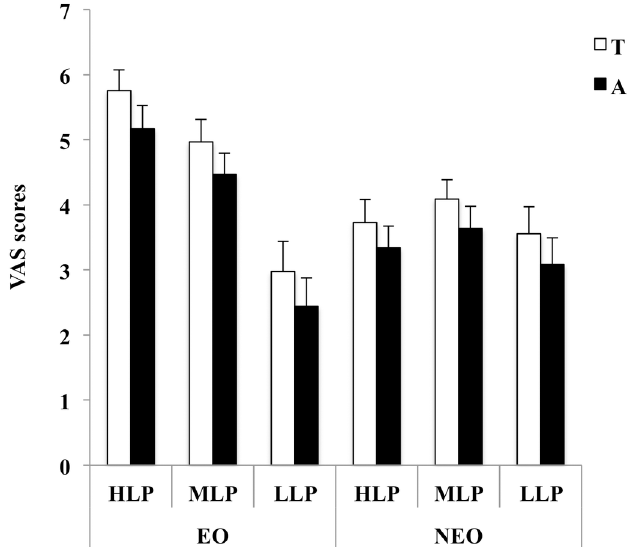
Fig 3. VAS scores (means ± SE) for technical ([T] white columns) and aesthetic ([A] black columns) qualities given by the expert (EO) and non-expert (NEO) observersto the swimmers ([HLP] high-level performers; [MLP] middle-level performers; [LLP] low-level performers). Values measuredat slow and fast pace were